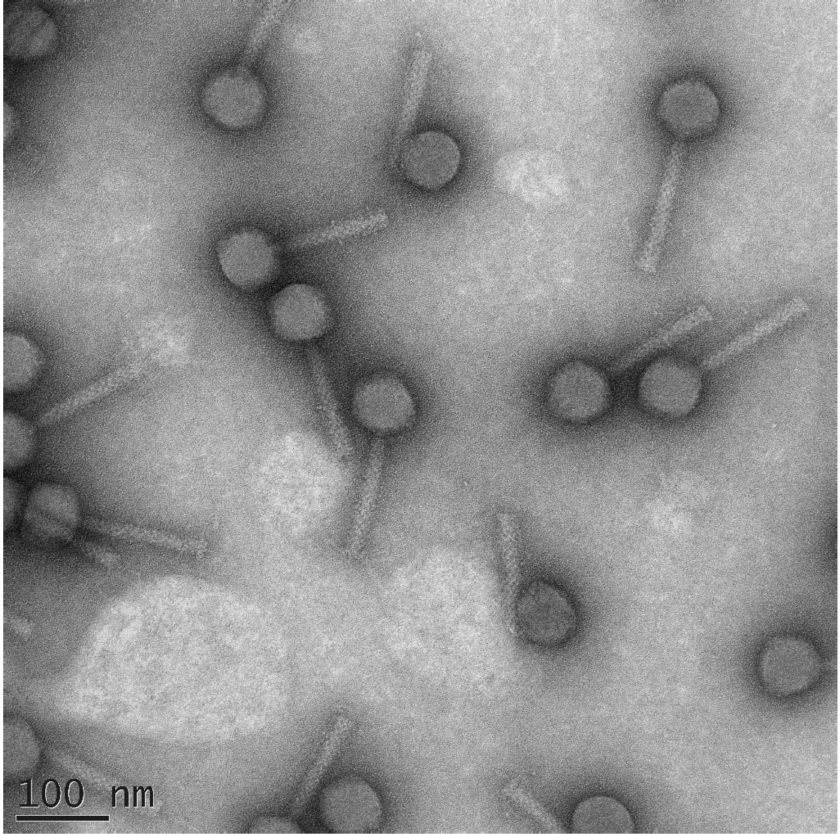
Figure 5. Transmission electron microscopy of Pectobacterium phage PP101 [102]. The scalebar is 100 nm. The image was kindly provided by Dr. Ekarterina